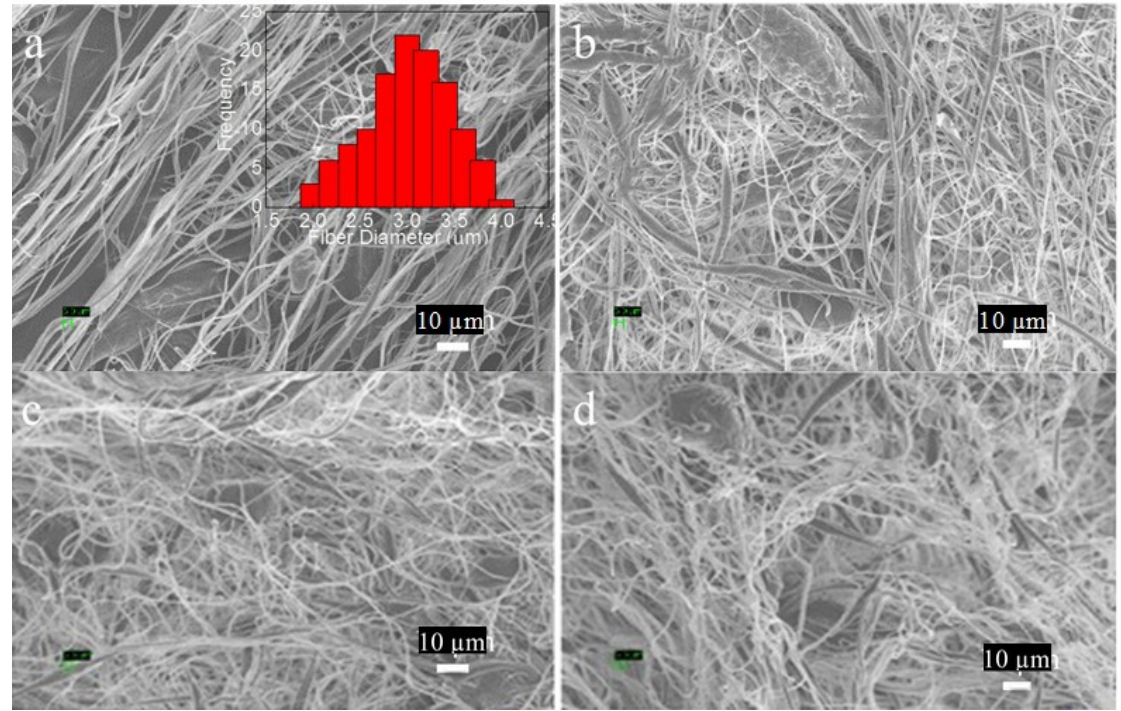
Figure 3. SEM images of PCL fibers prepared from 12.5 wt% PCL in solvent ratios of 50:50 (DMF:THF) mixtures and at different rotational speeds. ( a ) 5000 rpm; ( b ) 6000 rpm; ( c ) 7000 rpm; ( d ) 8000 rpm with a typical fiber diameter distribution in insert ( a ).